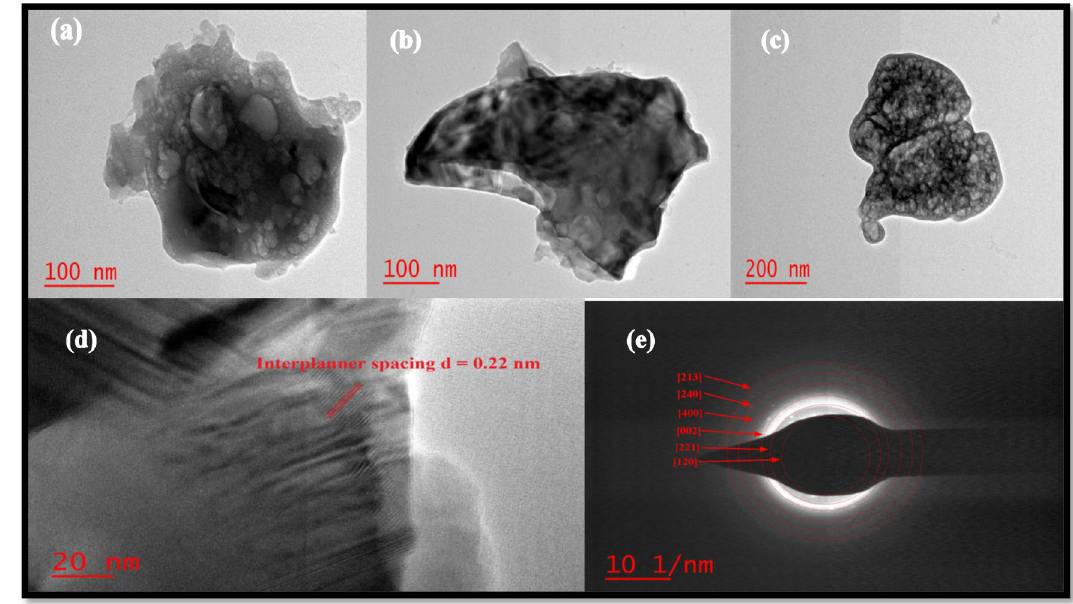
Figure 8. Sr 1−x Al 2 O 4 :Eu x (x = 0.05) phosphor TEM image ( a – c ) and HRTEM image ( d ) and SAED pattern ( e ).